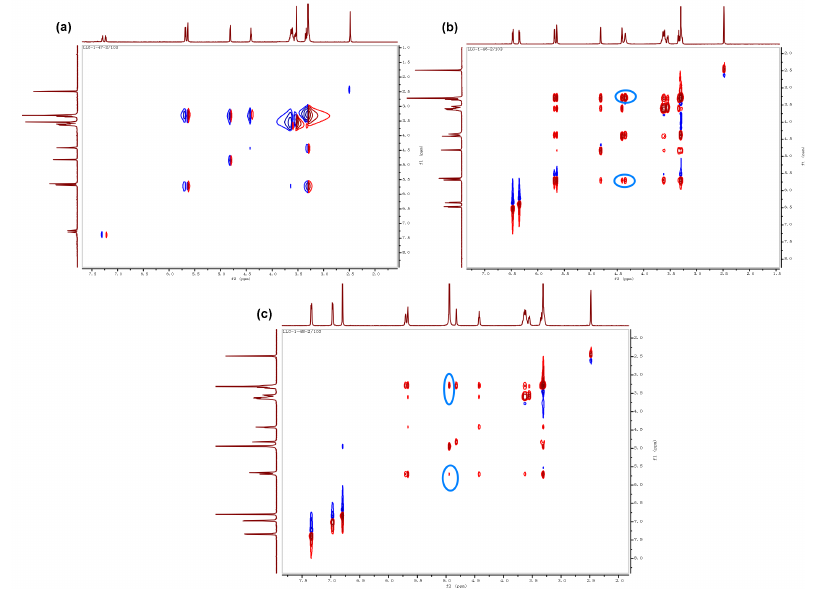
Figure 3. The 2D NOESY NMR spectra of freeze-dried: ( a ) 2-indanone (1.0 eqv.) and β -CD (15 mol%), ( b ) o-phenylenediamine (1.2 eqv.) and β -CD (15 mol%), and ( c ) 2,3-diaminonaphthalene (1.2 eqv.) and β -CD (15 mol%). Mixed after stirring in water for 12